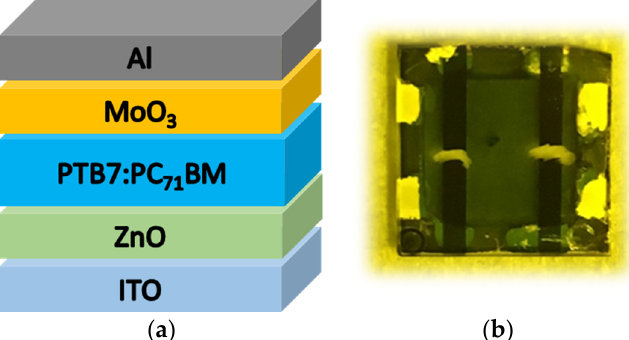
Figure 1. ( a ) Schematic illustration of device structure of inverted OPV and ( b ) photograph of inverted OPV cell.